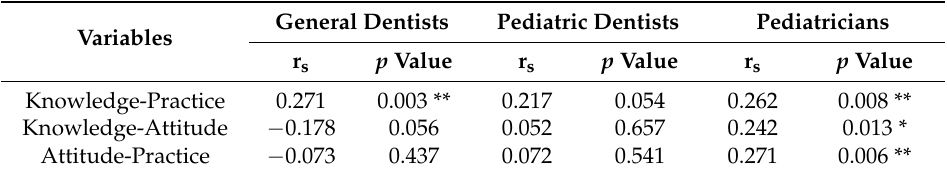
Table 5. Correlation between KAP scores in three